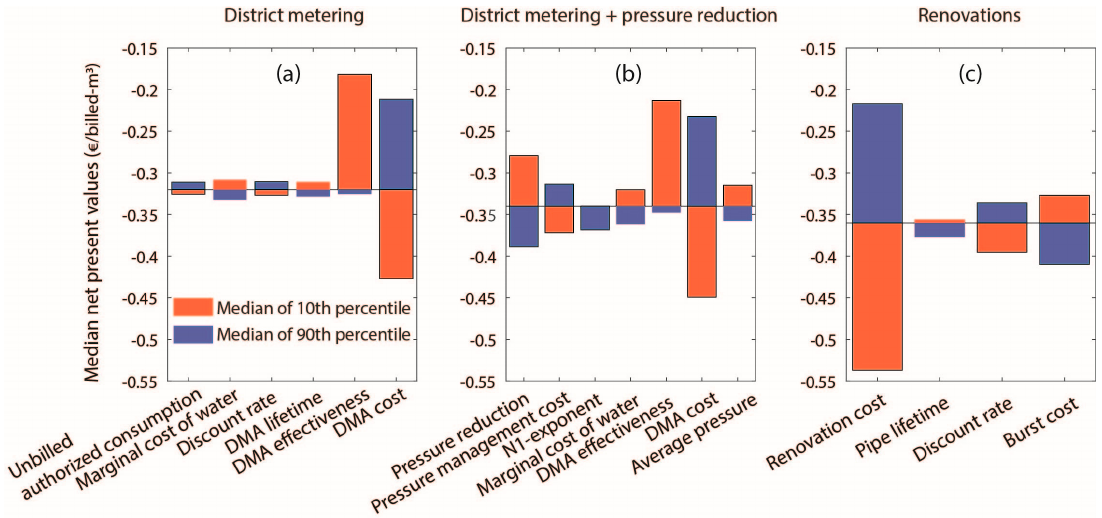
Figure 6. Median net present values for baseline (horizontal line) and the median of the 90th percentile (blue bar) and 10th percentile (red bar) results for: ( a ) District metering; ( b ) District metering with pressure reduction; and ( c ) Renovations.